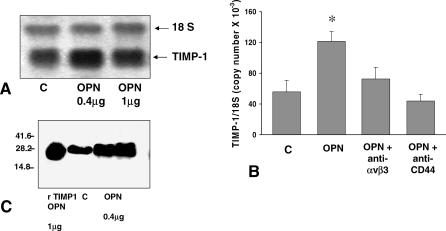
Effect of Osteopontin on TIMP-1 Gene and Protein Expression by Fibroblasts(A) Northern blot of 20 μg total cellular RNA per lane extracted from control and fibroblasts stimulated with 0.4 μg/ml and 1 μg/ml osteopontin. Both concentrations of osteopontin induced an increase of TIMP-1 expression.(B) The expression level of TIMP-1 by real-time PCR normalized to the level of 18S ribosomal RNA corroborates TIMP-1 up-regulation by osteopontin (*p < 0.01). In parallel experiments, osteopontin-stimulated cells were treated with anti-αvβ3 and anti-CD44.(C) Western blot demonstrating an increase of immunoreactive TIMP-1 in conditioned media from fibroblasts stimulated with osteopontin.C, control; OPN, osteopontin.